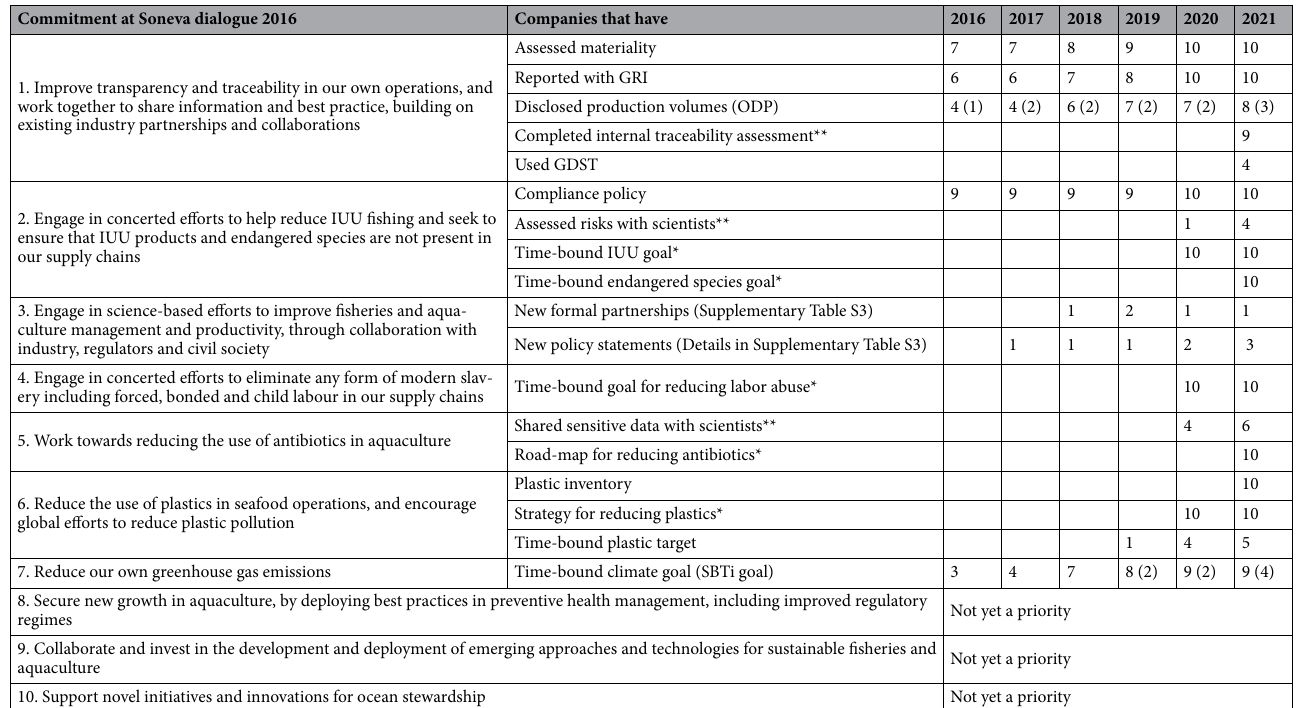
Table 3. Commitments and action towards ocean stewardship. *A common SeaBOS goal or activity, **information currently not available in the public record. Commitment 1–4 were identified as priorities